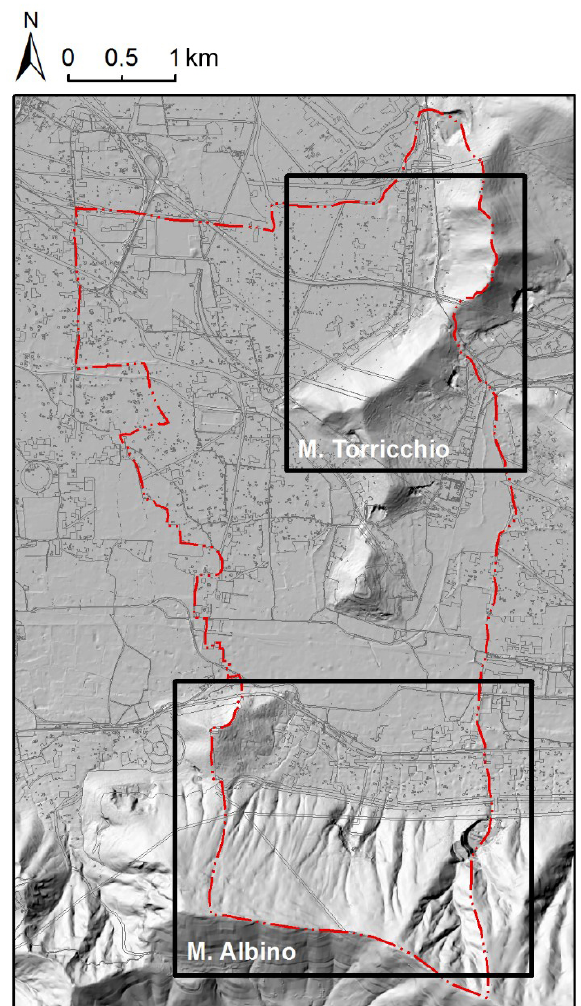
Figure 2. Geomorphologic setting and administrative boundaries of the Nocera Inferiore